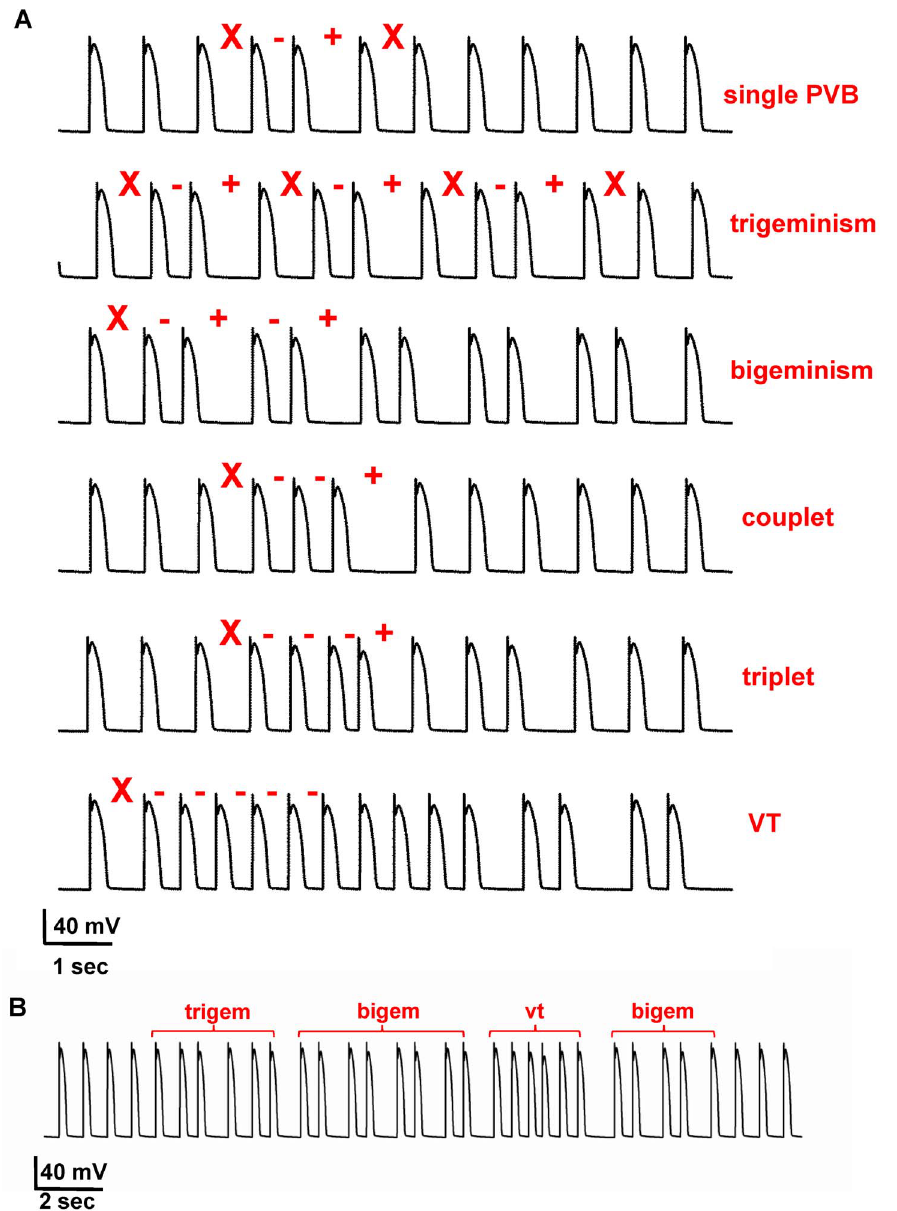
Figure 4. Our model suggests that all kinds of arrhythmia can be explained by dynamical fluctuations of the gap junctions. A) (top to bottom) isolated arrhythmia, trigeminy complex, bigeminy complex, couplet, triplet, short runs of tachyarrhythmias followed by a bigeminism; compare all panels with those in Fig. 2; B) 25 sec simulation exhibiting different types of arrhythmic behavior. In all cases, red markers highlight abnormal sequences (see Table 1); traces represent the membrane potential of cell(25,100), from simulations with the following average gap junction conductance and variance: (4.7, 0.3) iPVB, (4.9, 0.3) trigeminy, bigeminy, and triplet, (4.7, 0.6) couplet, (4.7, 0.8) VT.